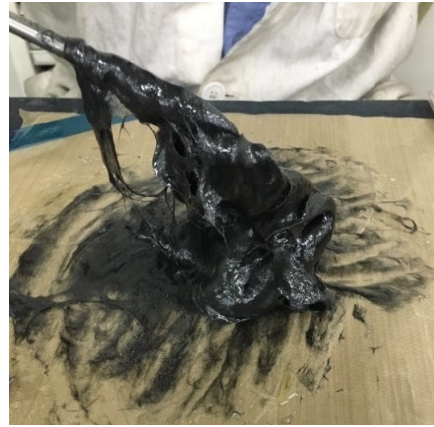
Figure 3. Short fiber composite materials before curing.